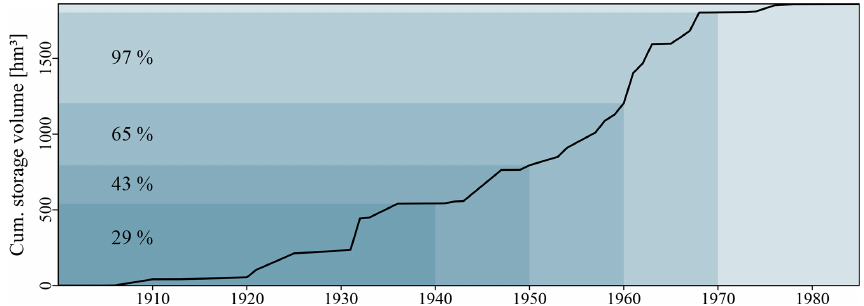
Figure E1. Cumulative storage volume of large storage lakes (active storage volume more than 0.3hm 3 ) in the High Rhine basin until gauge Basel. The figure is based on information presented in Wildenhahn and Klaholz (1996). Time frame displayed: 1900–1985.